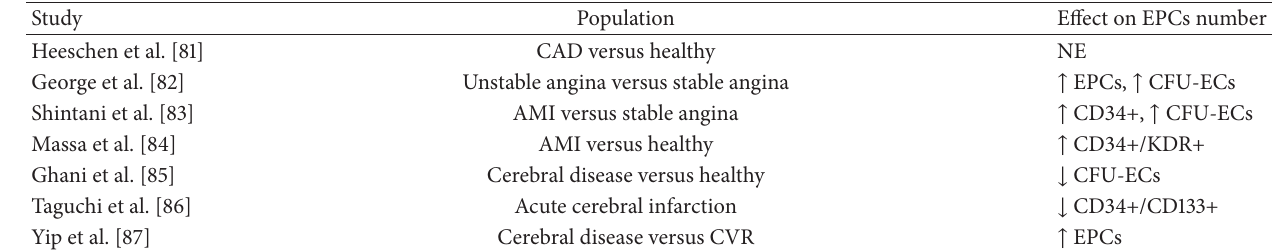
Table 6: CVD and